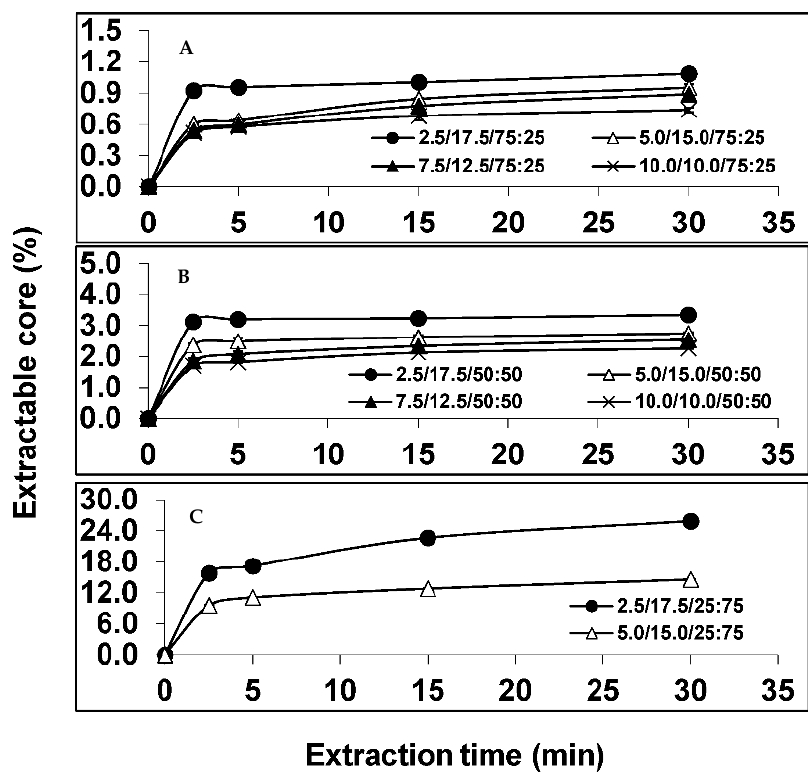
Figure 3. Effects of wall composition and extraction time on the extractable core from spray-dried microcapsules that were prepared with CIWEs at a wall-to-core ratio of 75:25 ( A ); 50:50; ( B ) and, 25:75 ( C ). Table 4. The effect of wall composition and wall-to-core ratio on microencapsulation efficiency. WHPI/lactose (%/%, w / w